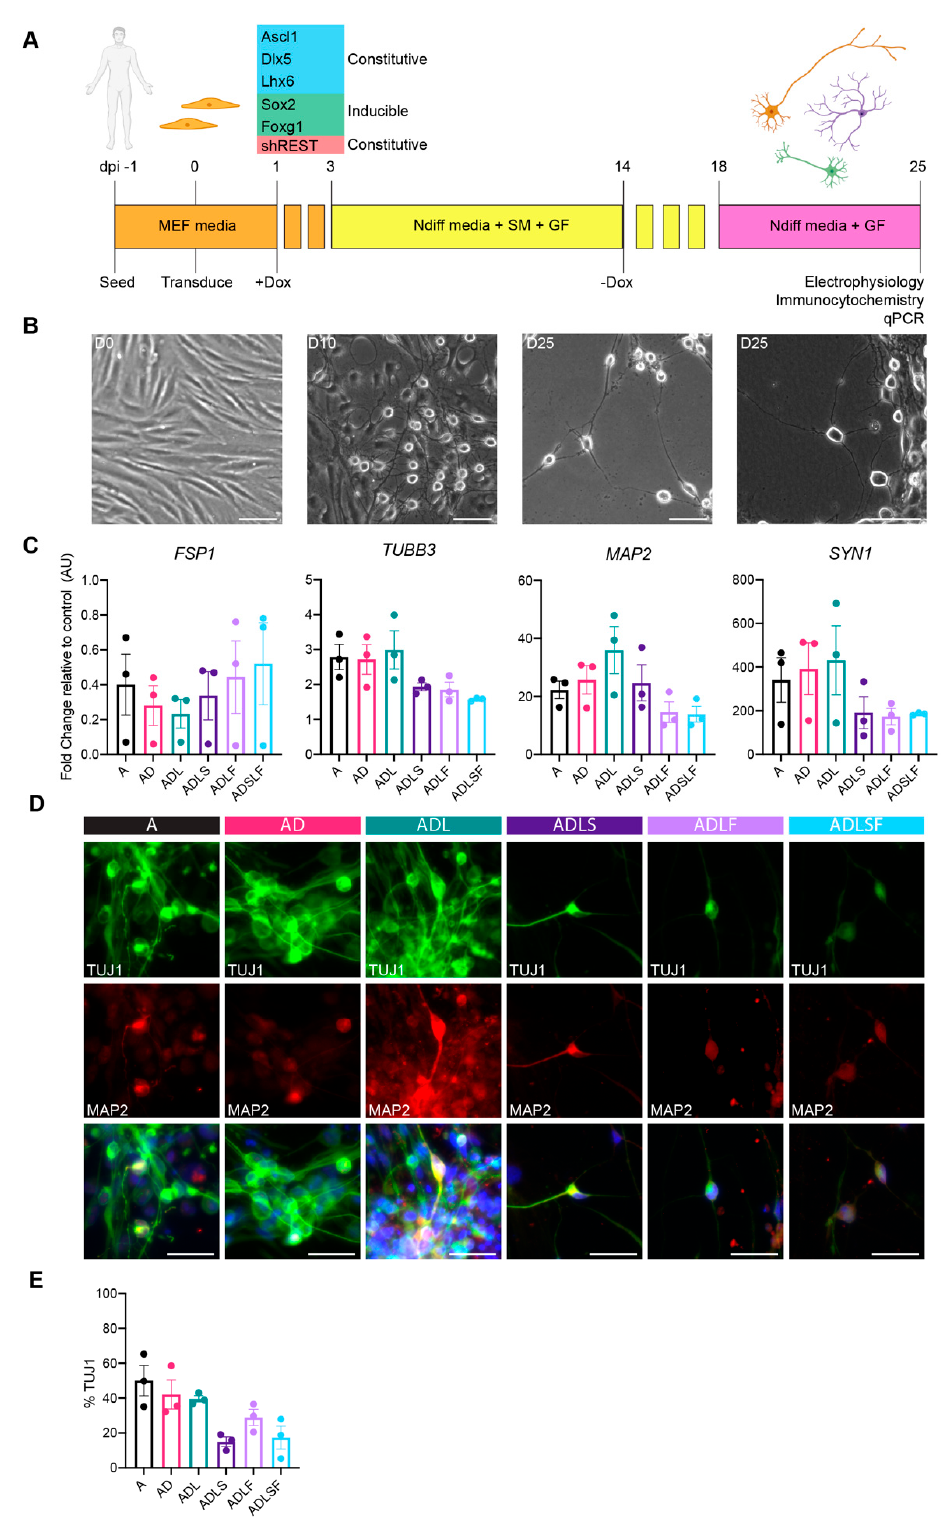
Figure 1. Conversion of adult human fibroblasts into neurons. ( A ) Schematic overview of the reprogramming protocol with different factor combinations. ( B ) Bright field images of cells in culture at day 0, day 10 and day 25. ( C ) RT-qPCR showing downregulation of fibroblast marker (FSP1) and upregulation of neuronal genes (TUBB3, MAP2 and SYN1) compared to fibroblast control across all conditions at day 25 ( n = 3). ( D ) TuJ1 and MAP2 immunocytochemistry of reprogrammed neurons across all conditions at day 25. ( E ) Neuronal purity quantified as TuJ1+ cells across all conditions at day 25. Scale bars represent 50 µ